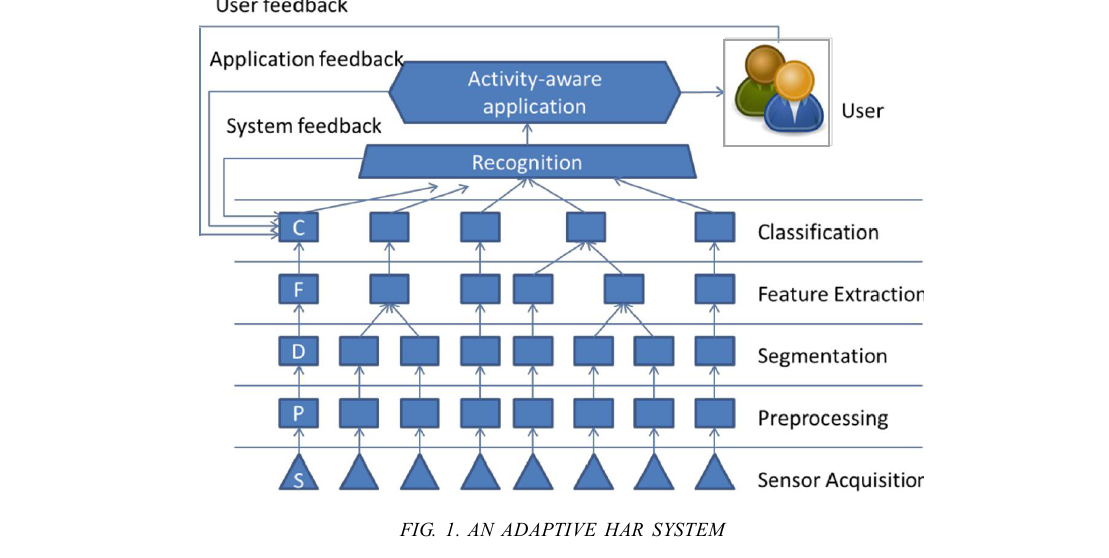
FIG. 1. AN ADAPTIVE HAR